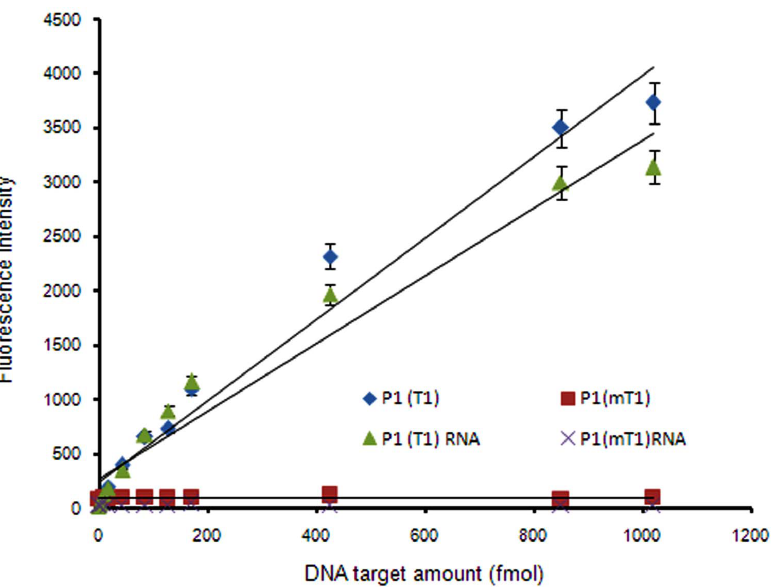
Figure 6. Fluorescence bead assay of T1 and m T1 HER2 targets with extraneous RNA background using P1 probe.